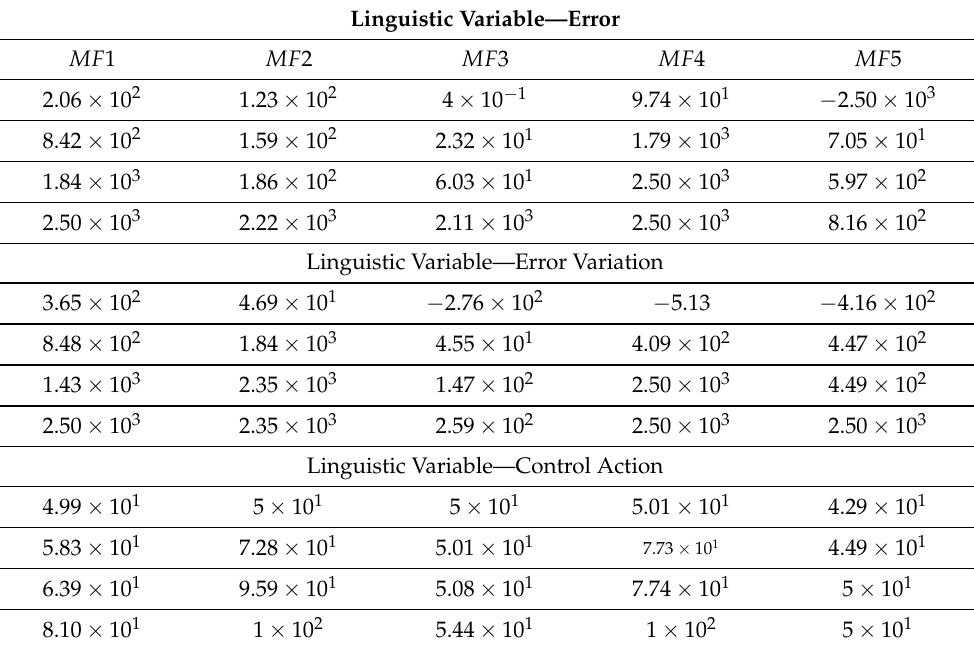
Table 5. Limits of the membership functions for the input and output variables of the fuzzy controller.